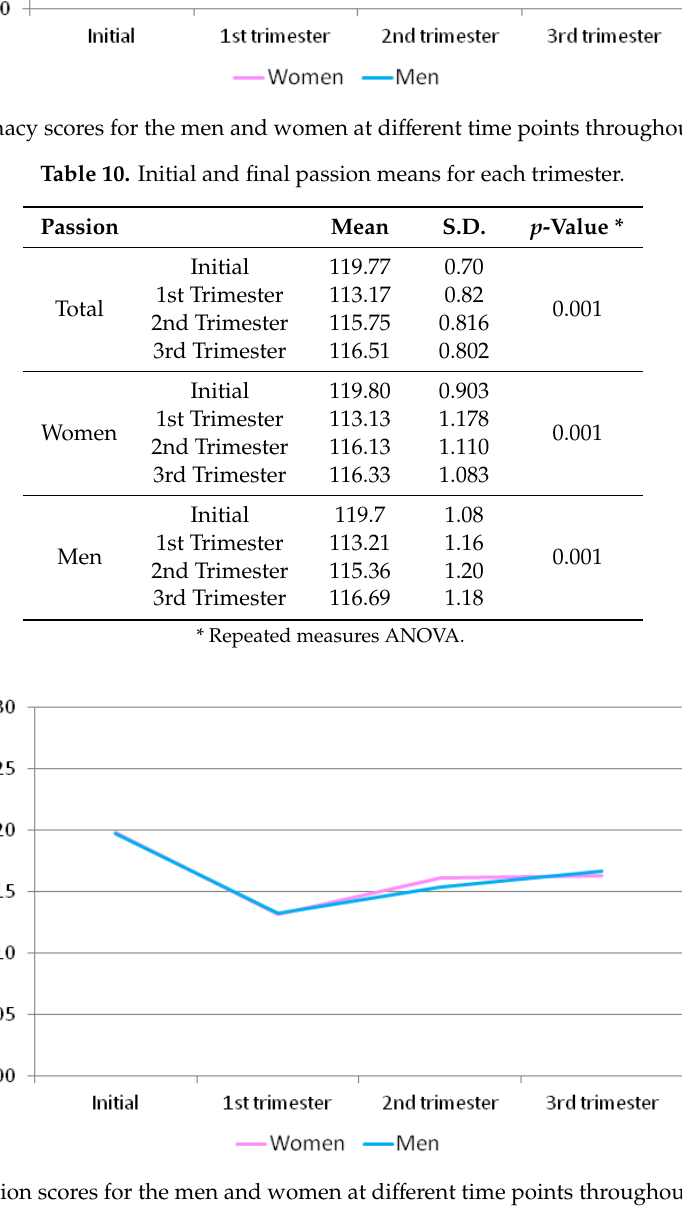
Table 11. Initial and final Commitment means for each trimester.